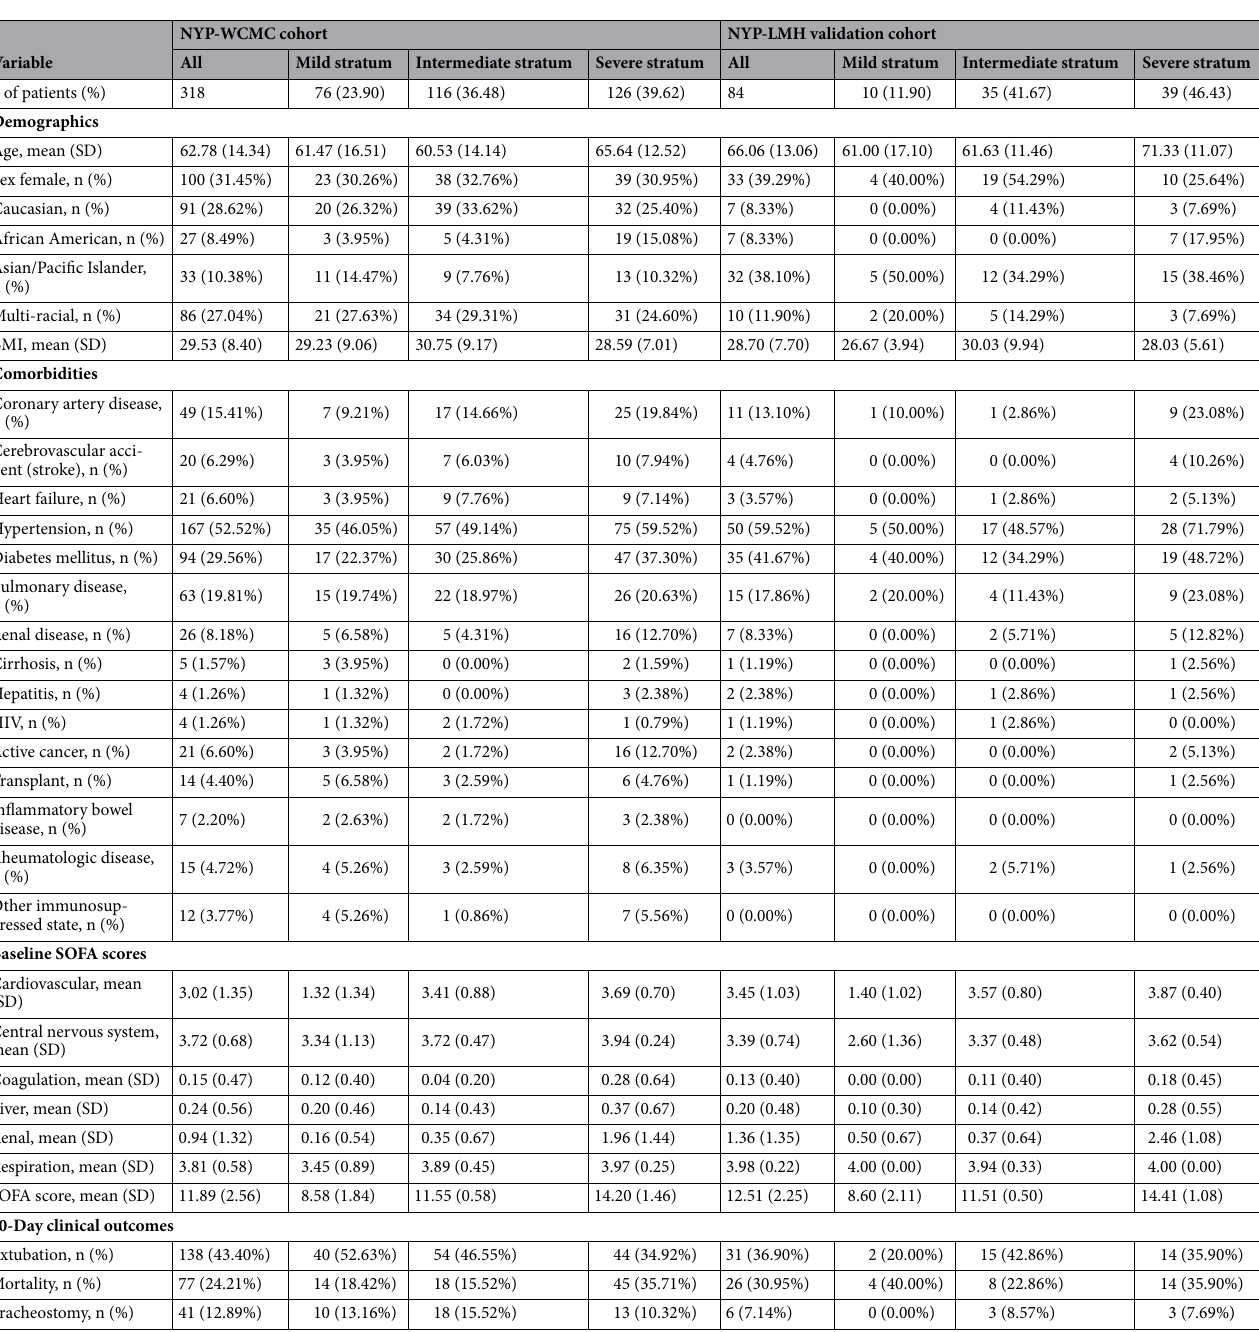
Table 1. Clinical characteristics of the studied cohorts. BMI Body mass index, HIV human immunodeficiency virus, NYP-WCMC New York Presbyterian Hospital-Weill Cornell Medical Center, NYP-LMH New York Presbyterian-Lower Manhattan Hospital, SD standard deviation, SOFA Sequential Organ Failure